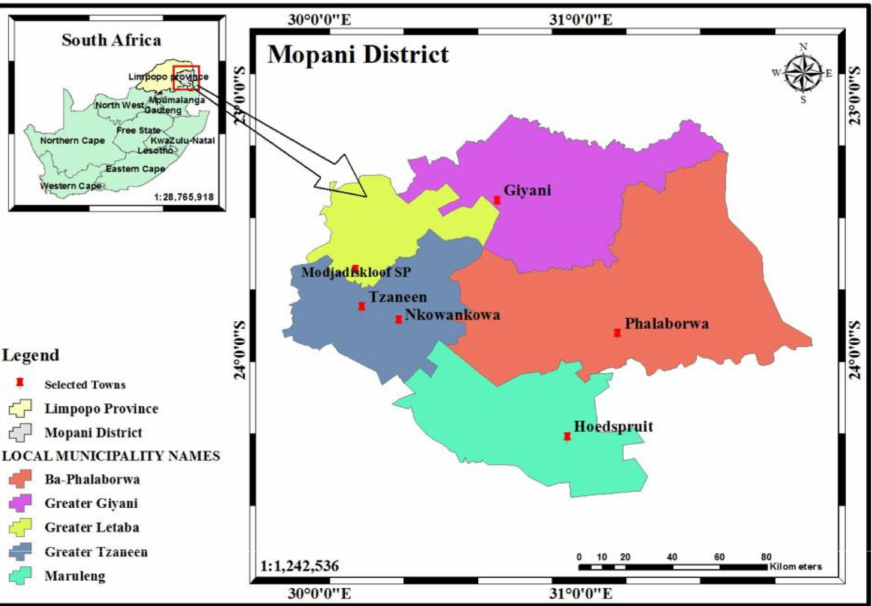
Figure 1. Mopani District showing the local municipalities and the selected towns within the context of Limpopo Province and South Africa (Source: Authors’ Field Data,